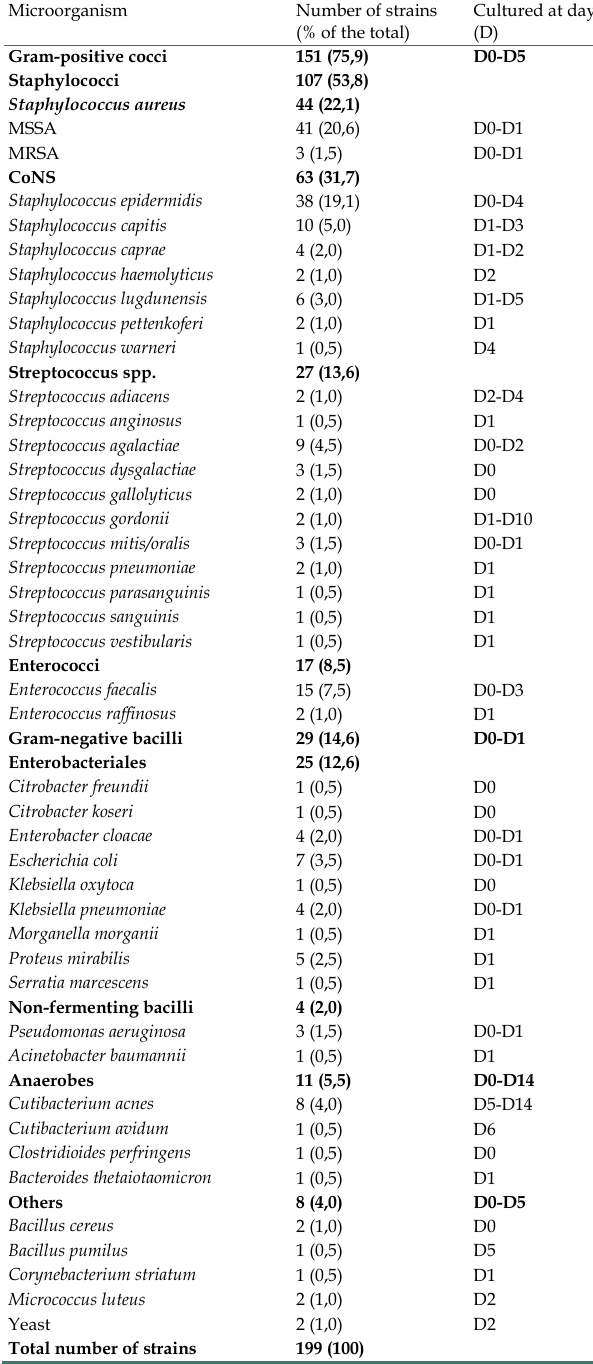
Cultured at day (% of the total) (D)